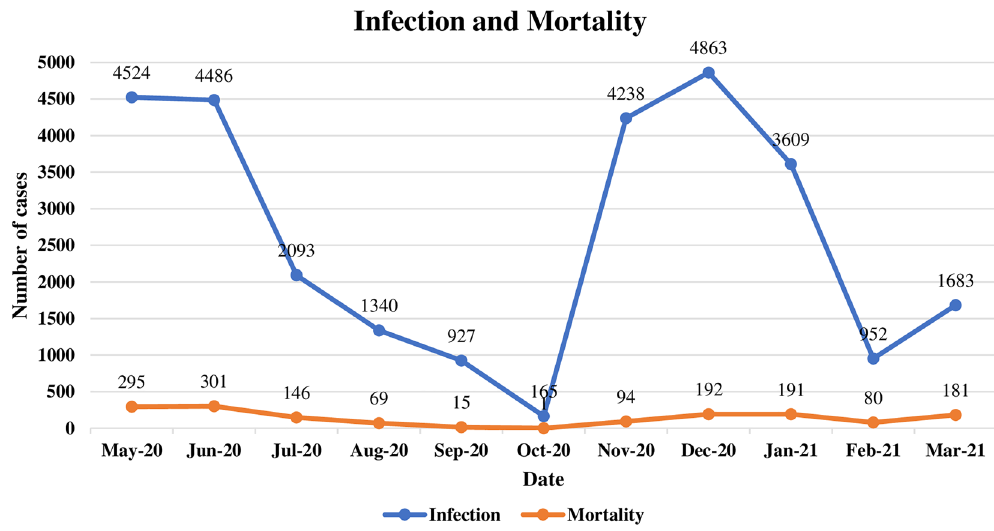
Figure 6. Correlation between COVID-19 infection and mortality over time (May, 2020–March,